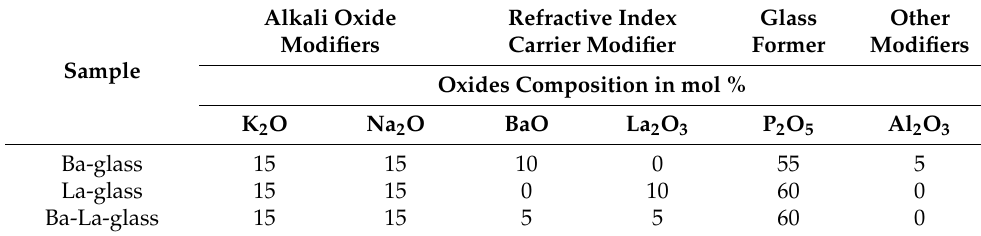
Table 1. Composition of the designed